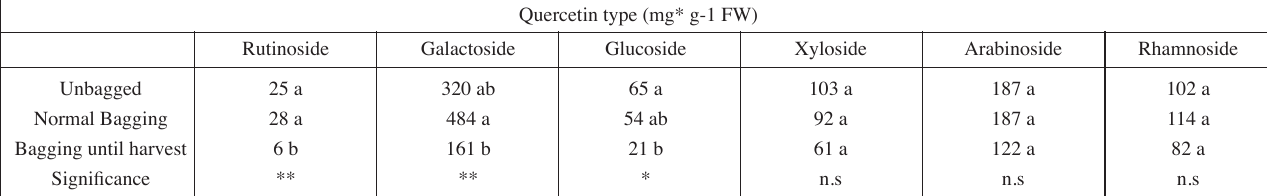
Tab. 8: Effect of bagging in quercetin glycosides of cv. Fuji. Efecto del embolsado en la concentración de quercetinas glicosiladas en piel de cv. Fuji.